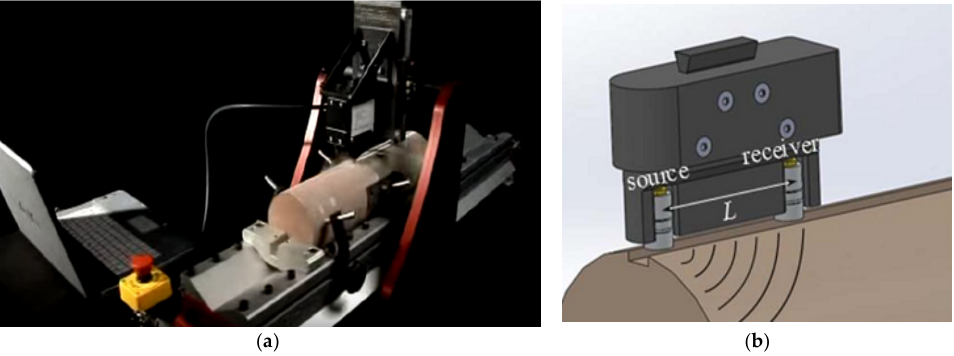
Figure 2. Scratch-test machine used in the study: ( a ) unconfined compressive strength (UCS) evaluation; ( b ) ultrasonic velocity acquisition.